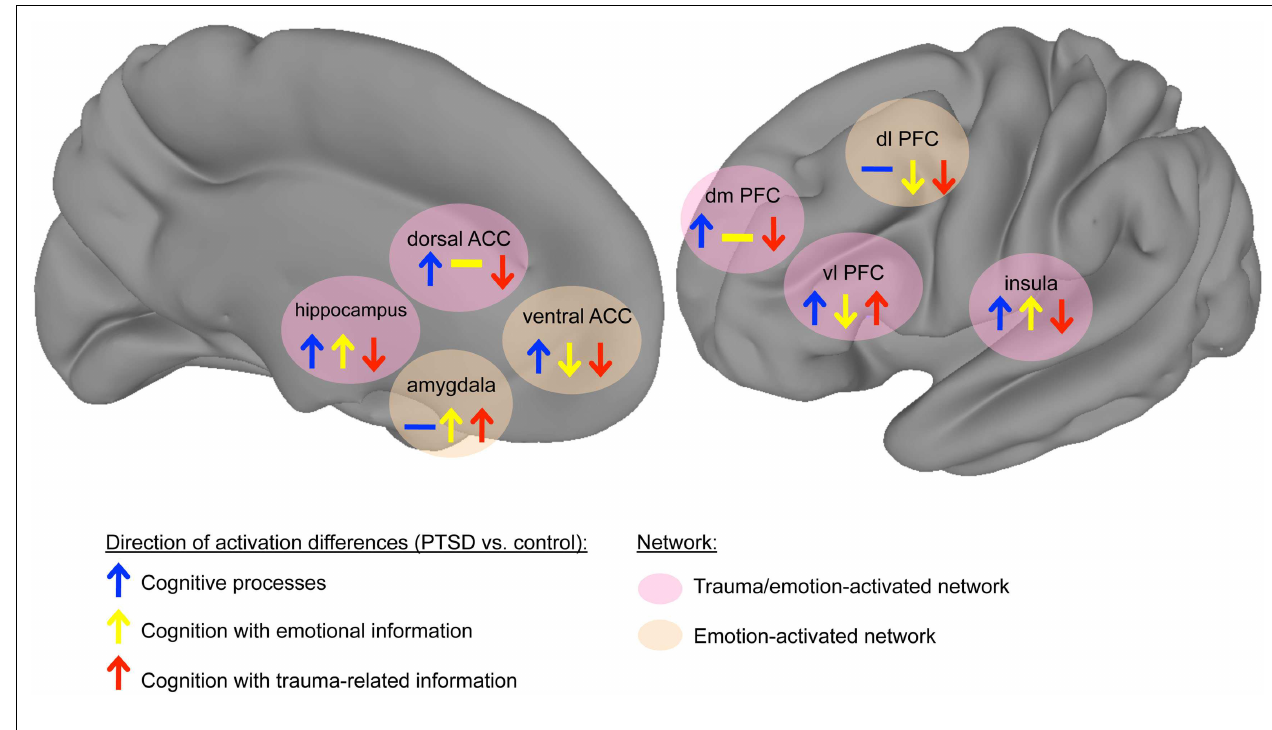
arrow: control > PTSD). Arrow colors indicate stimulus category (blue: cognition, yellow: cognition with emotional information, red: cognition with trauma-related information). Background colors of areas signify network (pink: regions differentially modulated by trauma-related information, tan: regions affected by emotion but not differentially modulated by trauma-related information). (Note: network connections are not specified because of a lack of published data describing changes in connectivity strength between nodes.Thus network connections are not explicitly shown, but implied to be consistent with known human